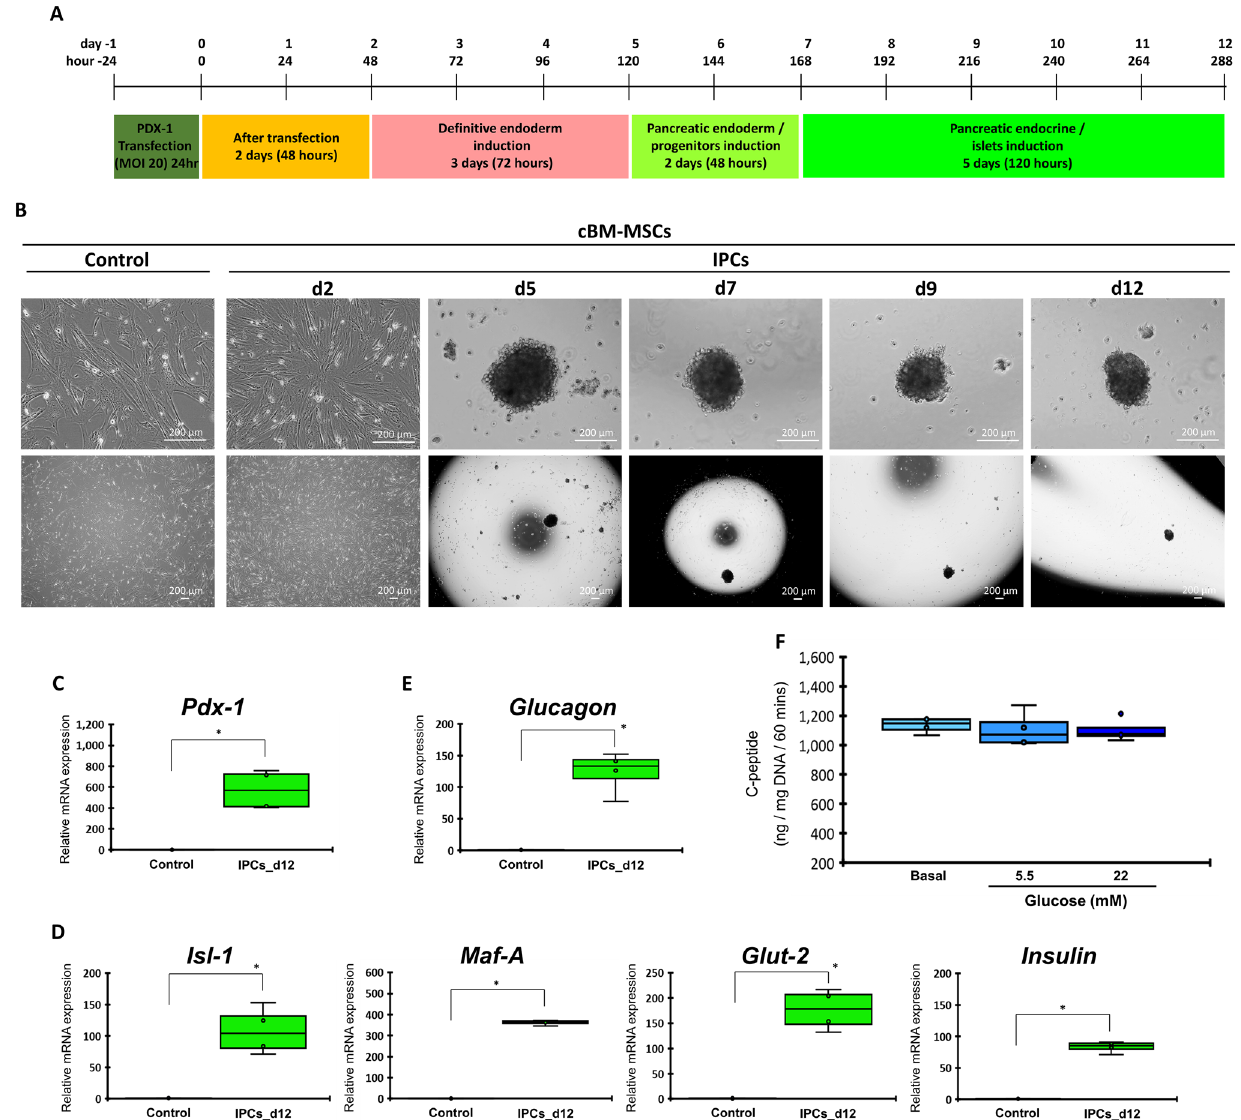
Figure 4. Generation of cBM-MSC-derived IPCs by integrating genetic and microenvironment manipulation. Diagram of culture technique used for the generation of cBM-MSC-derived IPCs is shown in ( A ). Morphological appearances of cells that underwent induction technique were observed under a phase-contrast microscope with magnification of 40X and 200X ( B ). mRNA markers relating to pancreatic endoderm ( C ), pancreatic beta-cell ( D ), and pancreatic-relating markers ( E ) were analyzed by RT-qPCR. mRNA expression was normalized with a reference gene and undifferentiated control. Functional testing by glucose-stimulated C-peptide secretion (GSCS) was illustrated ( F ). Bars indicate a significant difference (*, p value <